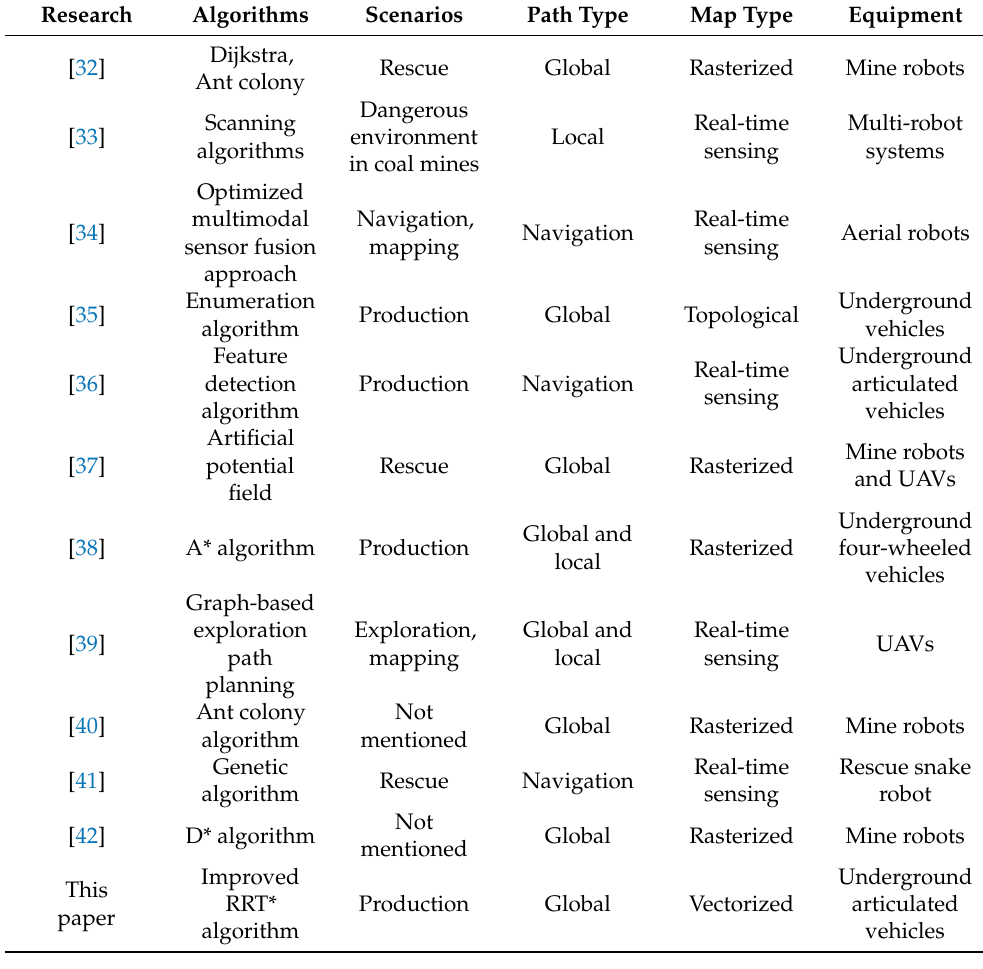
Table 1. Comparation of typical underground mine path planning